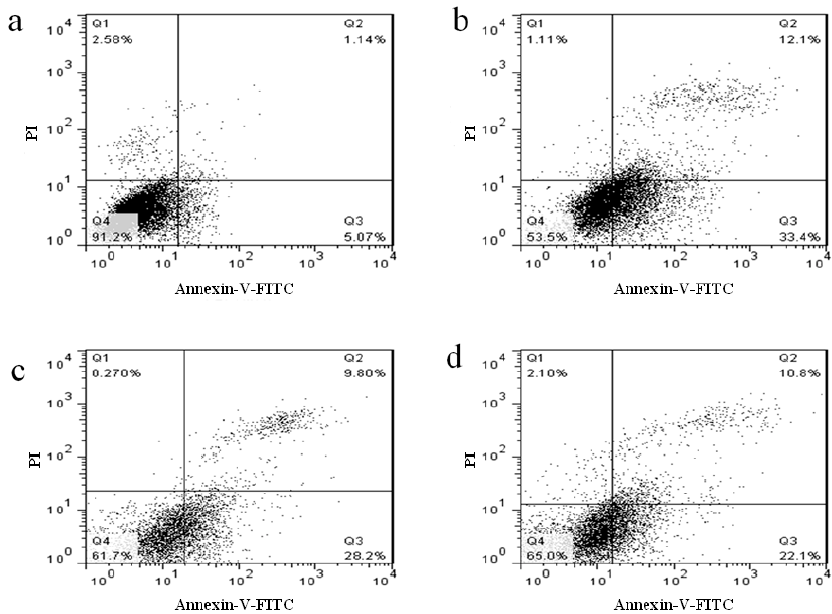
Figure 6. Cell apoptosis was measured by labeling the cells with Annexin-V-FITC and counterstaining with PI. ( a ) CK; ( b ) damage group; and ( c , d ) sample group. The numbers indicate the percentage of cells in each quadrant (lower left: FITC − /PI − , intact cells; lower right: FITC+/PI − , apoptotic cells; upper left: FITC − /PI+, necrotic cells; and upper right: FITC+/PI+, late apoptotic cells).